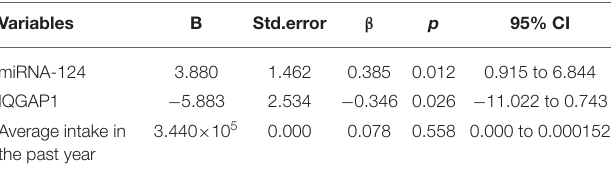
TABLE 3 | Linear regression analysis: analysis of independent influencing factors of OASI score. Variables B Std.error β